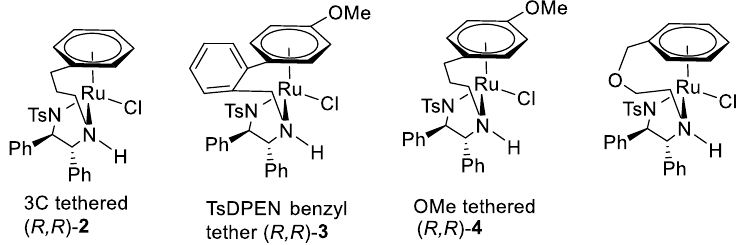
Figure 6. Tethered catalysts introduced by Wills et al. ATH of some benzophenone derivatives [9,13,14] and heterocyclic ketones [15 – 17] has been reported. The electronic differences between two phenyl rings caused by the electron-donating p -OMe group and electron-withdrawing p -CN group make the p -OMe substituted phenyl ring adopt the position proximal to the η 6 -arene. Out-of-plane aro- matic rings with one or two ortho -substituent groups favour positioning distal to η 6 -arene and result in the formation of alcohol products with very high ees (Figure 7).